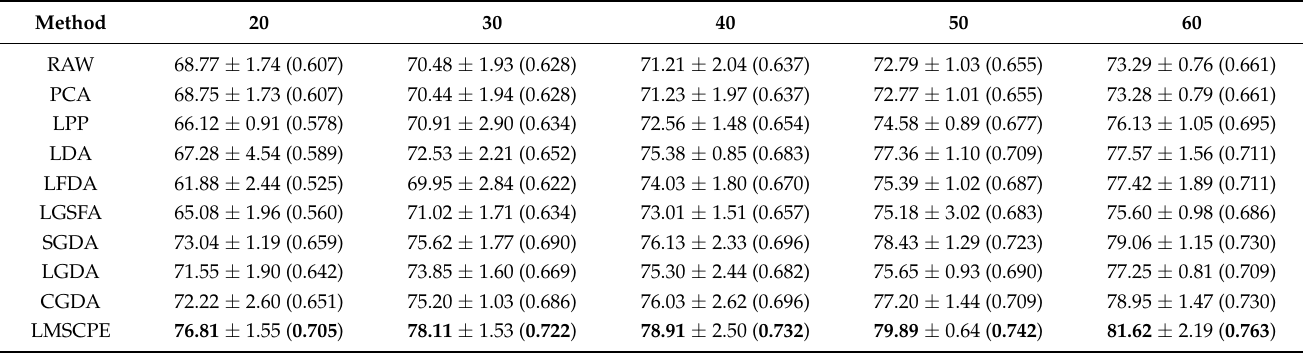
Table 1. Classification results of each method with different training sample sizes on the PaviaU dataset [OA ± STD (%)(KC)]. (OA—overall classification accuracy, STD—standard deviation, KC—kappa coefficient, and the best results of a column are marked in